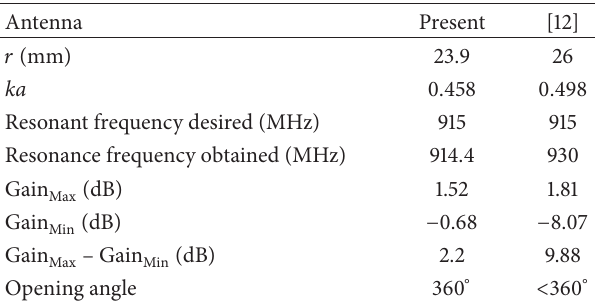
Table 5: Comparison between this work and the work